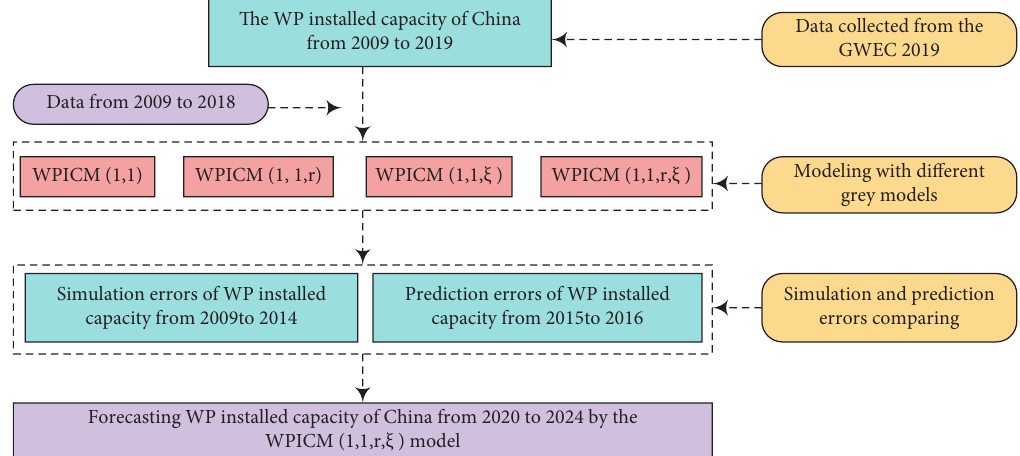
Figure 3: Structure chart of